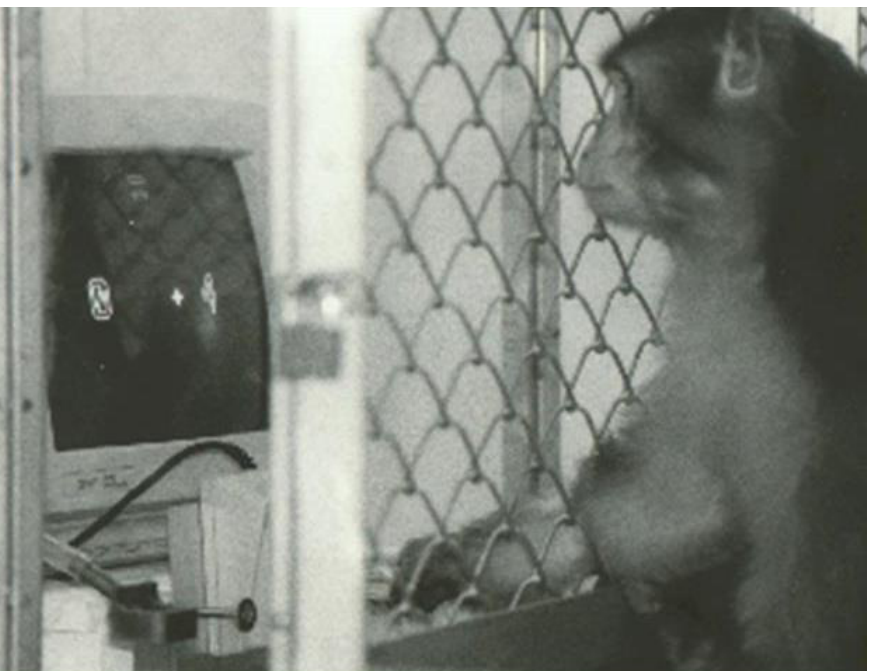
Figure 1 . A monkey reaches through the mesh of his cage to manipulate a joystick in a typical Rumbaughx